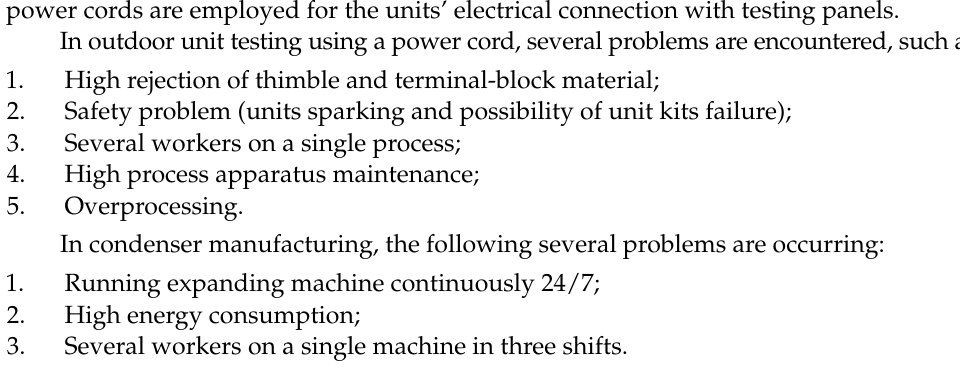
Figure 3. The capacity of expanding machine and welding line. 2.1.1. Stakeholders Key stakeholders defined by the project team for both case studies are given below in Figure 4.